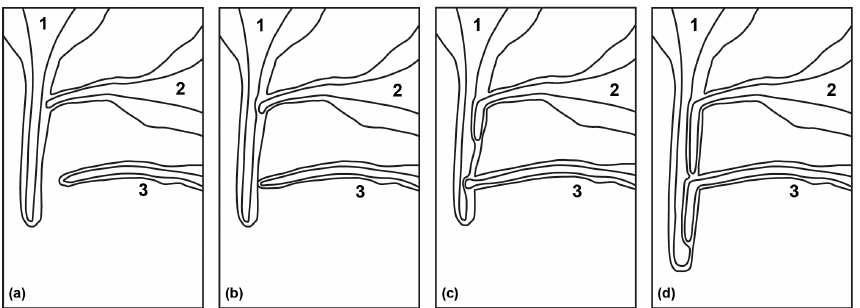
Figure 5. Sketch map of selected possible interactions among surging glaciers of different types. (a) At the beginning, glacier 2 in full surge mode, (b) surge maximum of glacier 2 and surge start of glacier 3, (c) surge maximum of glacier 3, and (d) surge of glacier 1. See text for